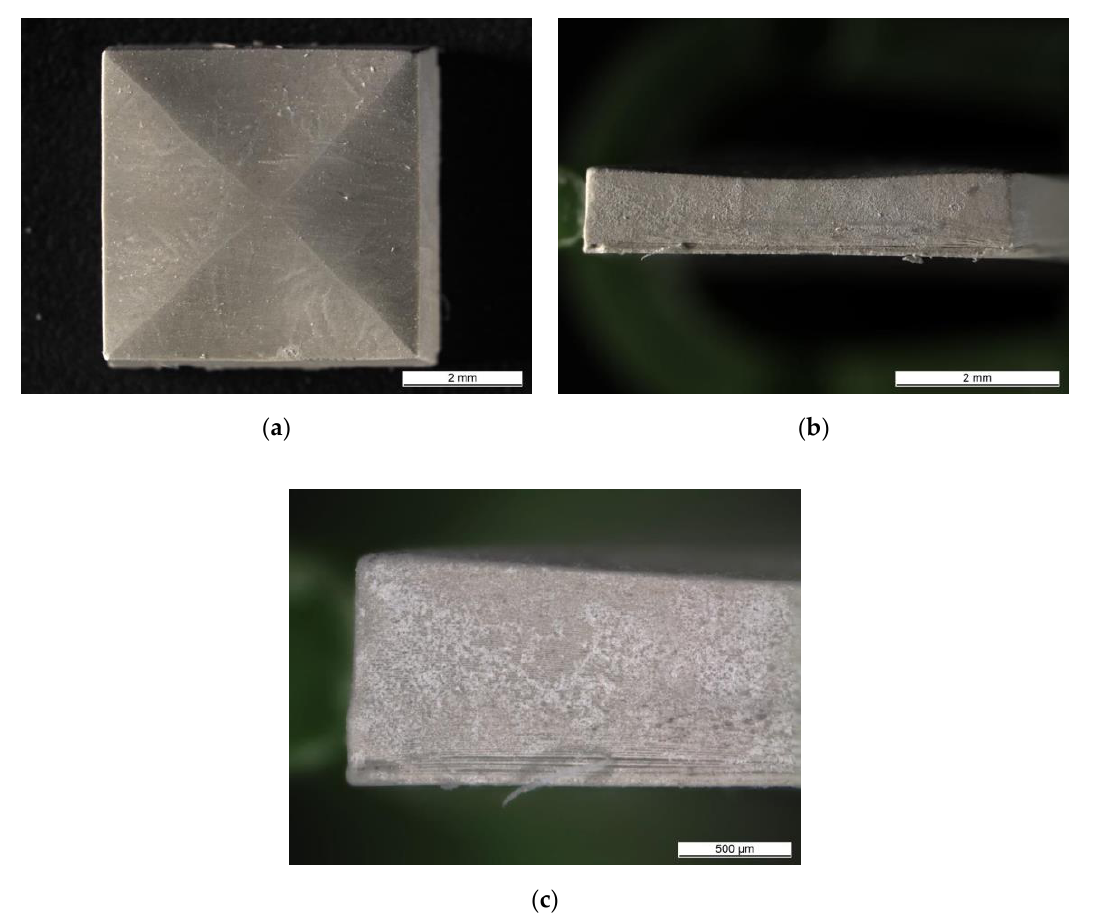
Figure 8. The structure fabricated on the LCM device from a suspension containing 0.5 wt % TPO-L and 10 µm printing layer thickness. ( a ) top view, ( b ) side view, ( c ) side view—higher